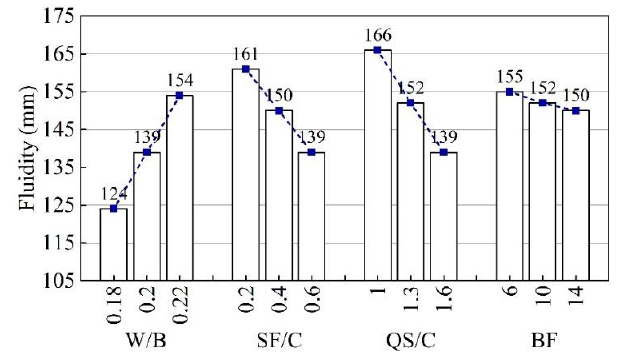
Figure 4. Fluidity of the BFRPC.